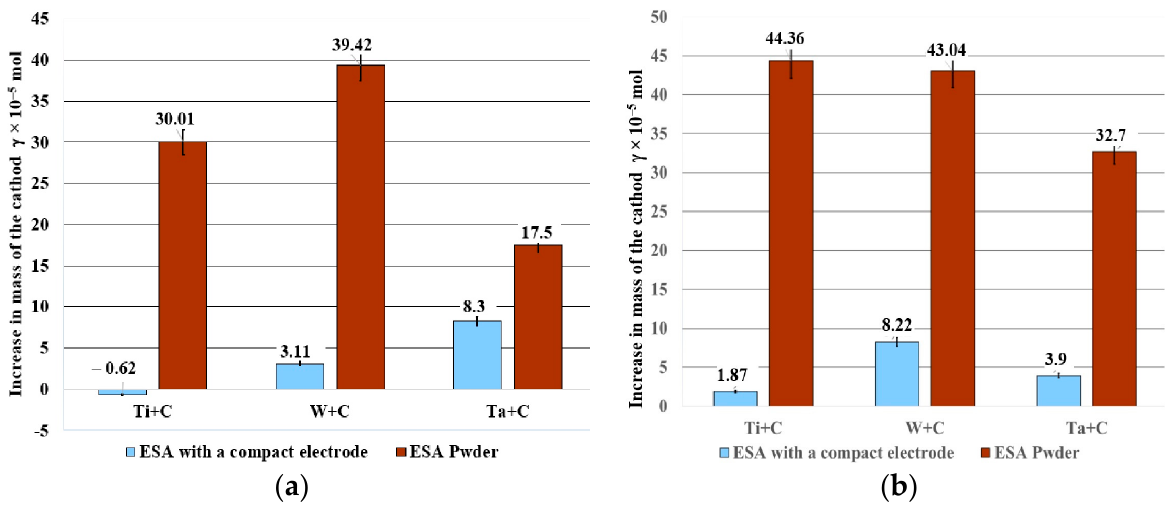
Figure 2. Histograms of cathode mass growth rates in the cases of ESA with compact and with additional supply of-powder when the mode of the discharge energy was Ер = 0.3 J: ( a ) cathode—C45, ( b ) cathode—commercial titanium BT1.